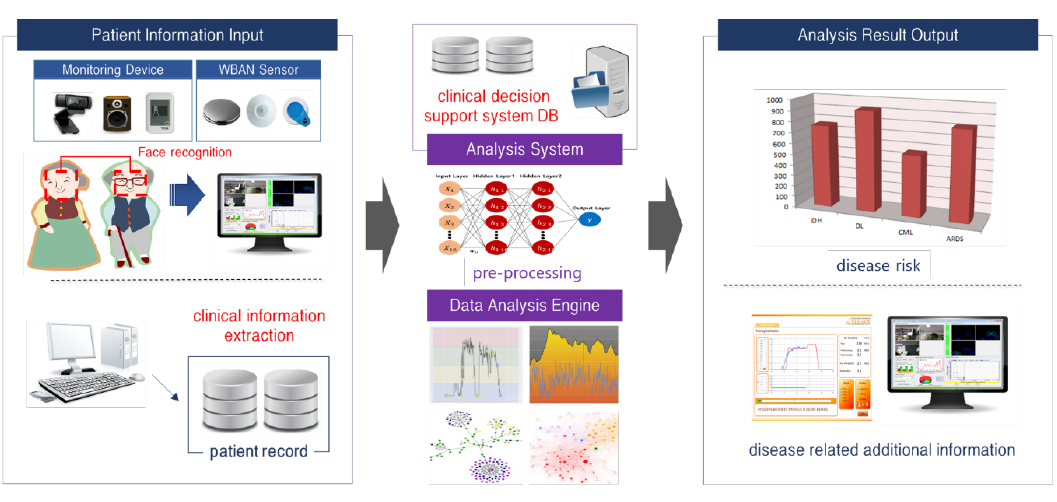
Figure 1. Facial expression and bio-signal-based lifecare service.